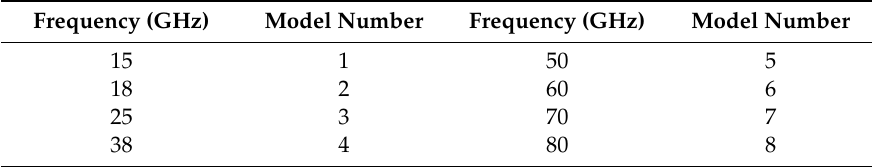
Figure 6. Test set accuracy of the ELM, DT, and PNN for ( a ) single-frequency, ( b ) dual-frequency, and ( c ) tri-frequency models, respectively. Table 2. Model numbers of single-frequency models.